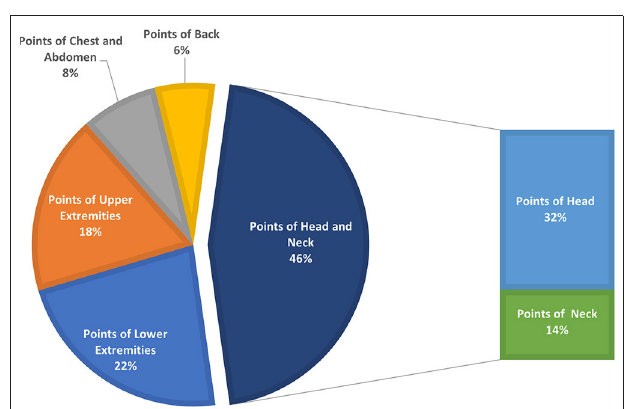
FIGURE 6 | Frequency of site of point application for TD treatment.